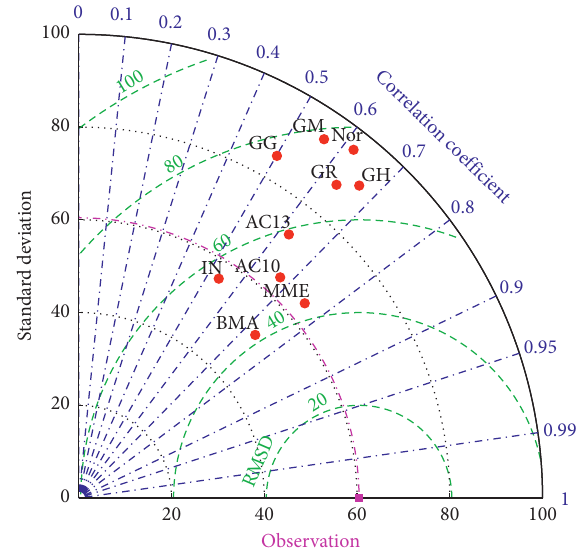
Figure 6: Taylor diagram for the 8 GCMs, MME, and